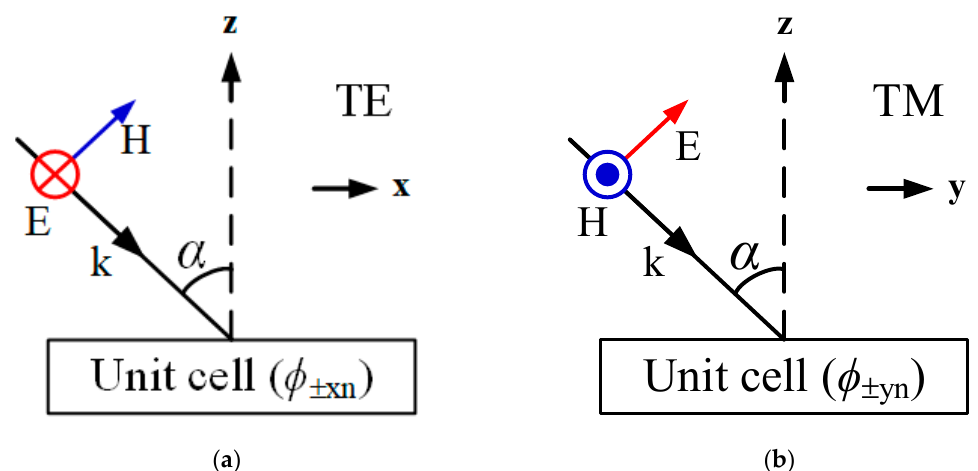
Figure 7. Unit cell simulations for two different incident modes of ( a ) a transverse electric (TE) and ( b ) a transverse magnetic (TM) with the incidence angle α